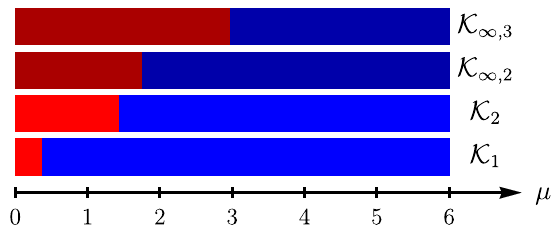
Fig. 2 Nonclassicality of boson-added states p a † ρ μ a + (1 − p ) ρ μ with p = 0.5. For each μ , we highlight whether the different criteria detect the corresponding probability distribution as nonclassical (red) or not (blue). Note how restricting to the fi rst three Fock-state probabilities, when only K 1 and K 1 ; 2 are accessible, nonclassicality is certi fi ed only up to μ ~ 1.7. On the other hand, knowing P 3 , nonclassicality is certi fi able up to μ ~ 3, thanks to K 1 ; 3 .